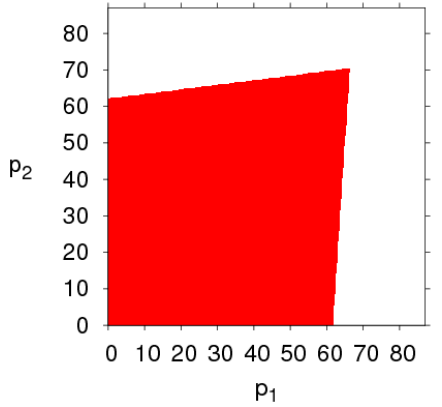
Figure 17. Basins of attraction of dynamic system (6), α 1 = α 2 = 0.005, λ 1 = 0.8 .